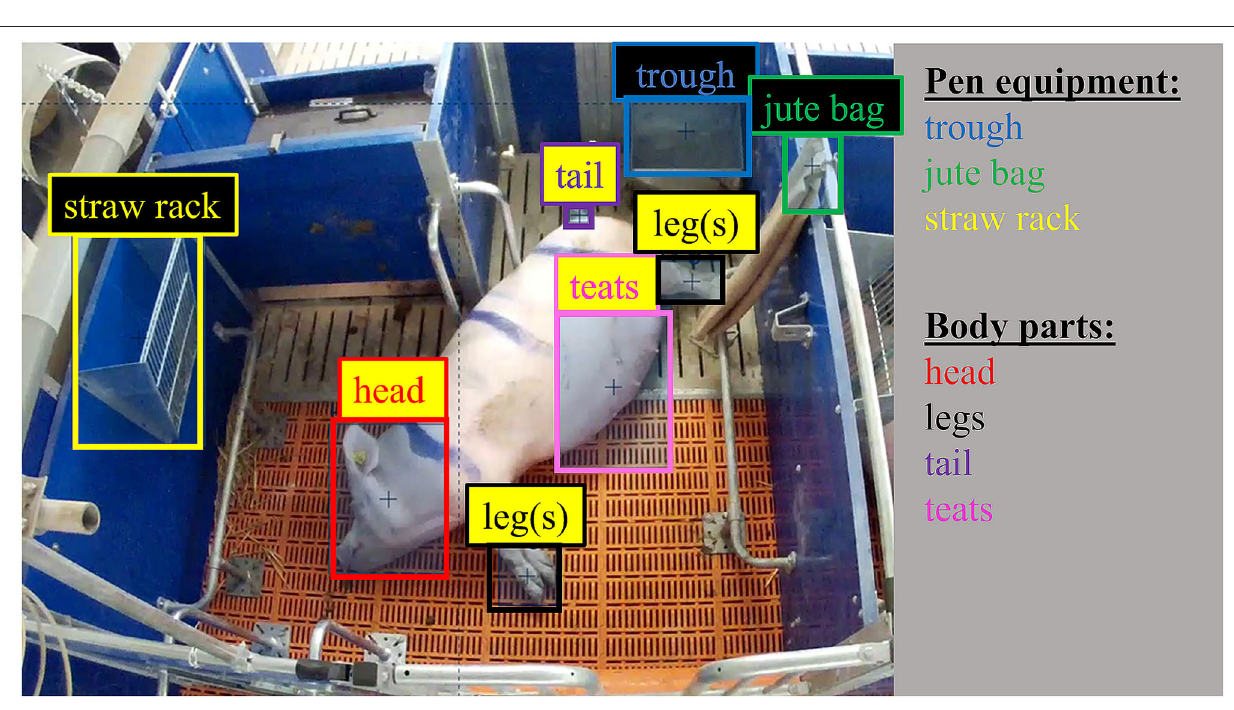
As starting weights, pre-existing YOLO V3-weights 2 , which are pre-trained on the ImageNet-dataset 3 , were used. In